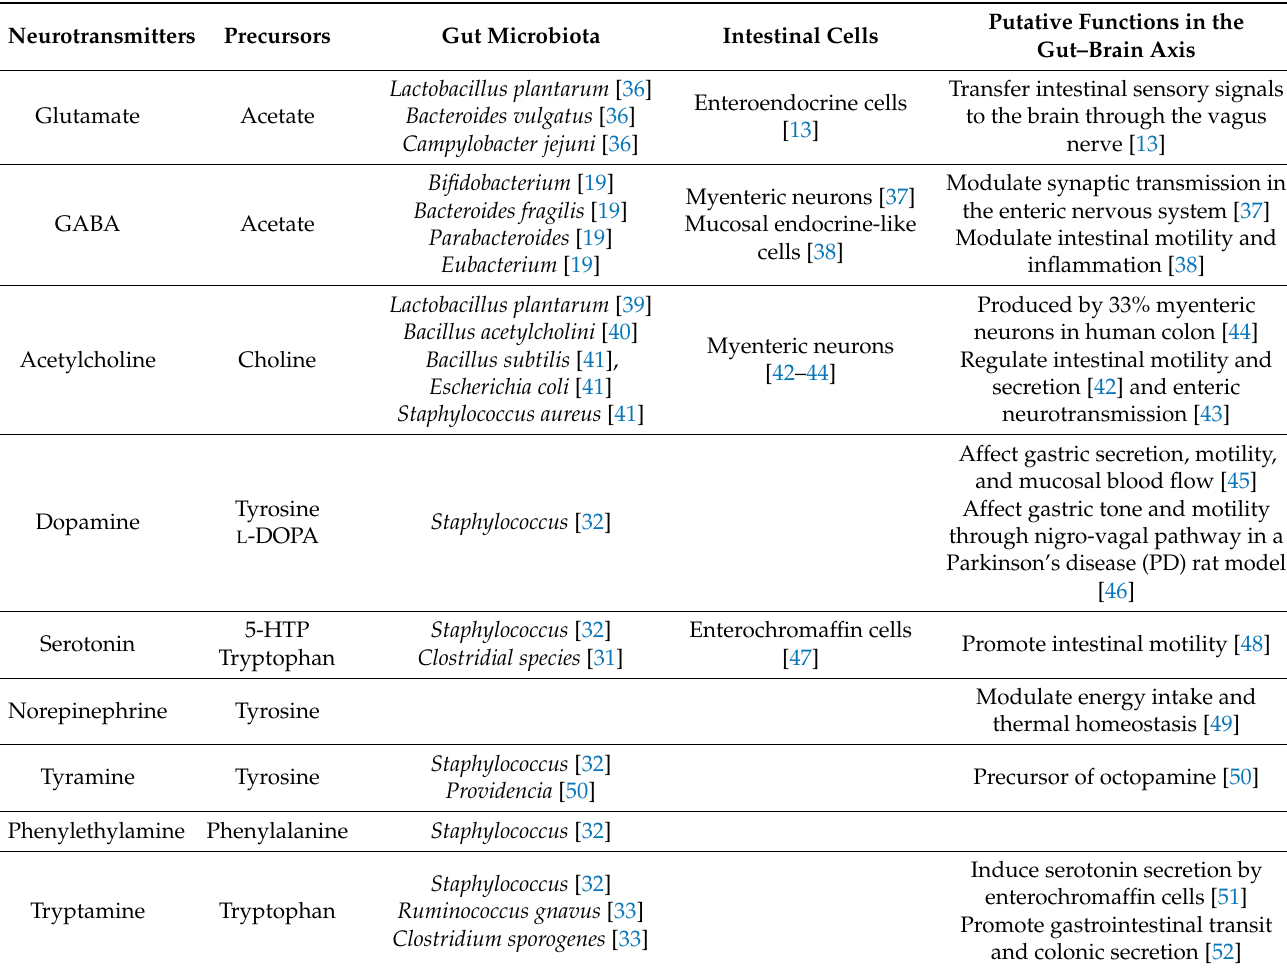
Table 1. Gut microbiota-regulated neurotransmitter synthesis and functions in the gut–brain axis. A list of specific neurotransmitters and their precursors, synthesis in particular bacterial taxa or in intestinal cells, and the putative functions of these neurotransmitters in the gut-brain axis. Abbreviations: 5-HTP, 5-hydroxytryptophan; GABA, gamma-aminobutyric acid; L -DOPA, L -3,4-dihydroxy-phenylalanine; PD, Parkinson’s